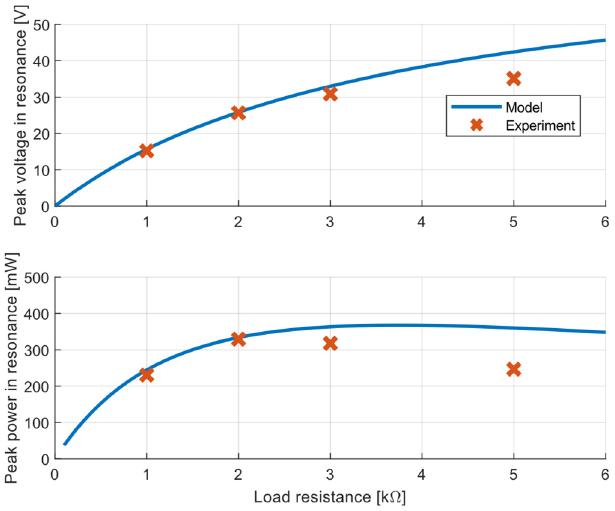
Figure 7. Voltage and power responses in resonance operation vs. load resistance—simulation results and measurements with excitation acceleration amplitude of 1 ms − 2